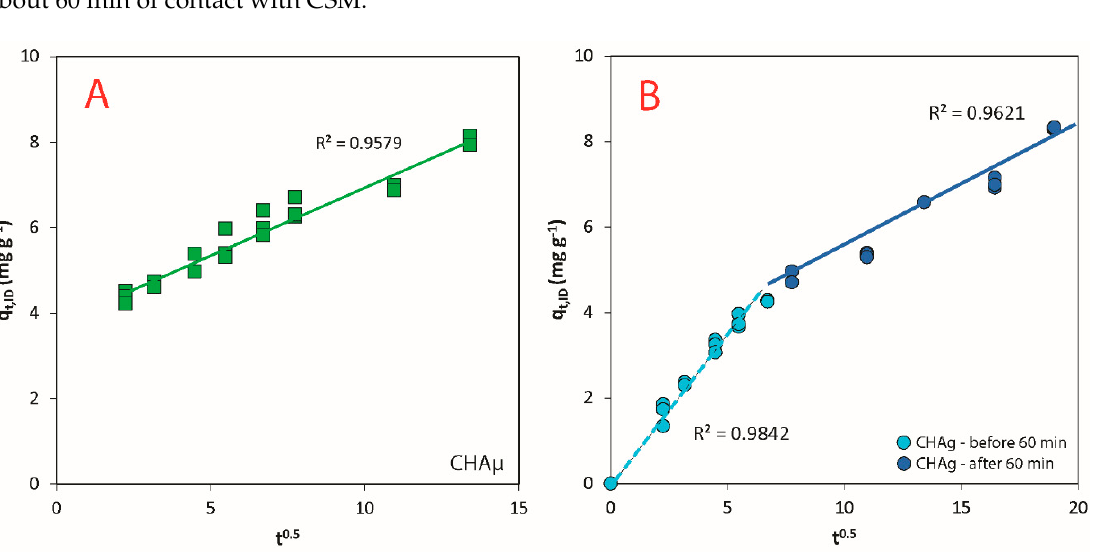
Figure 4. ID plots ( t 0.5 against q t ID , Equation (12)): ( A ) linear regression for CHA µ with relative R 2 ; ( B ) ID model for CHAg; the leftmost line represent data before the first hour of contact while in the rightmost part there are data after the firsts 60 min; the graph shows two distinct regions with di ff erent ID parameters; R 2 values are reported.